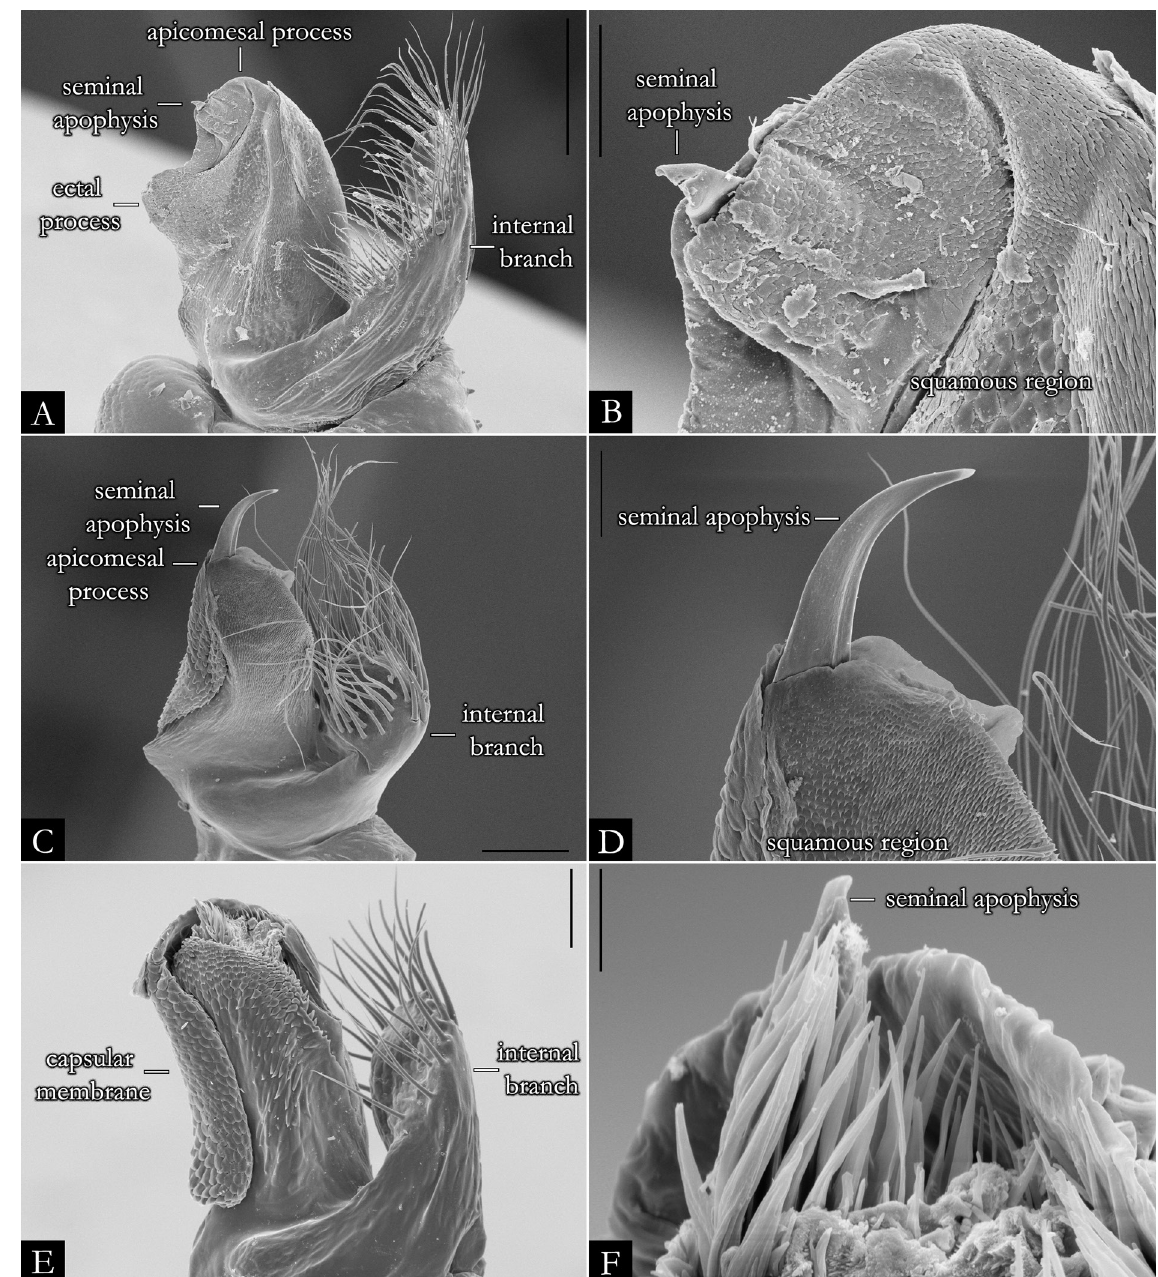
Fig. 35. SEM images of telopodite of right gonopod, in anal view. A . Pseudonannolene microzoporus Mauriès, 1987 (IBSP 5733). B . Detail of apical region, P. microzoporus (IBSP 5733). C . P. maritima Schubart, 1949 (IBSP 979). D . Detail of apical region, P. maritima (IBSP 979). E . P. spelaea Iniesta & Ferreira, 2013 (IBSP 6071). F . Detail of apical region, P. spelaea (IBSP 6071). Scale bars: A = 0.3 mm; B, E = 0.05 mm; C–D = 0.1 mm; F = 0.2